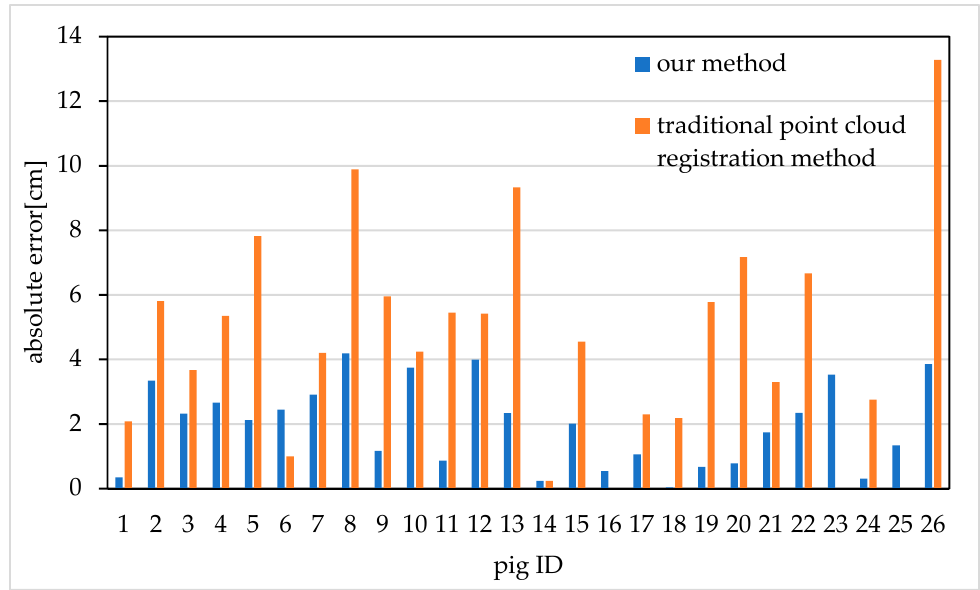
Figure 11. Absolute errors of pig heart girth measurements after using different registration methods.